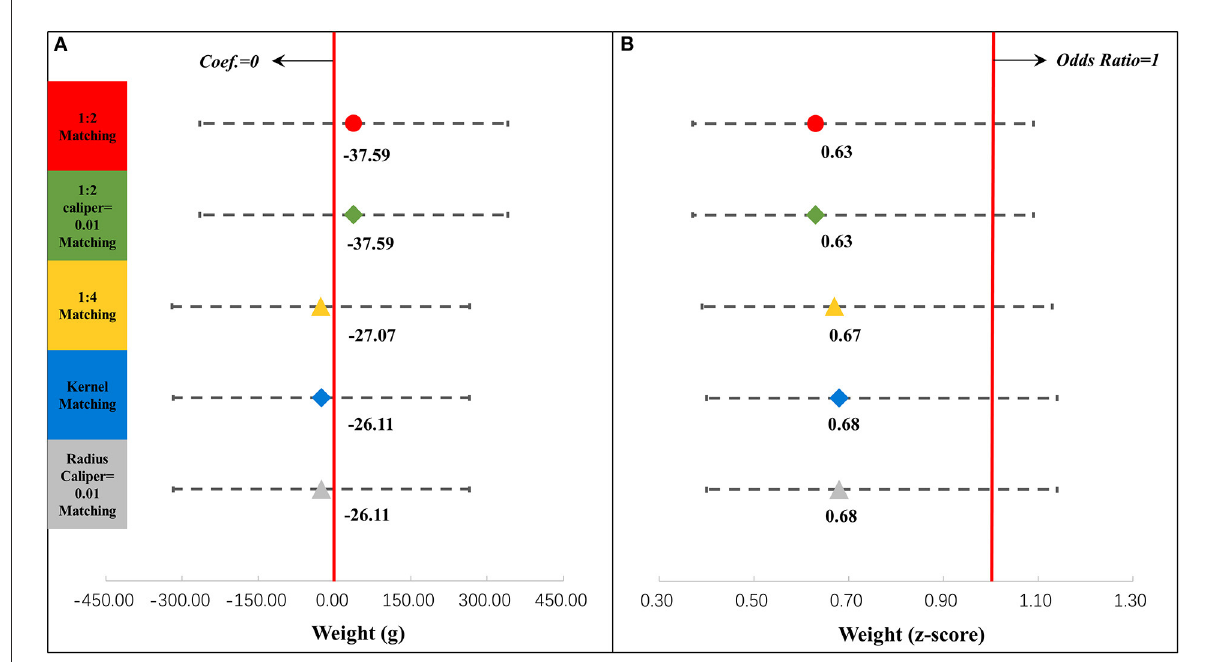
FIGURE6 Results of regression analysis of weight (A) and the weight z-score (B) after propensity score matching. * P < 0.05, ** P < 0.01, *** P < 0.001. The results of different propensity score matching analyses are reported too. Dots and lines represent means and 95% confidence intervals for Coef. or ORs estimated from generalized linear mixed regression analyses. Maternal, family, and infant characteristics were also included in the regression analyses but are not shown. Details are reported in Supplementary Table